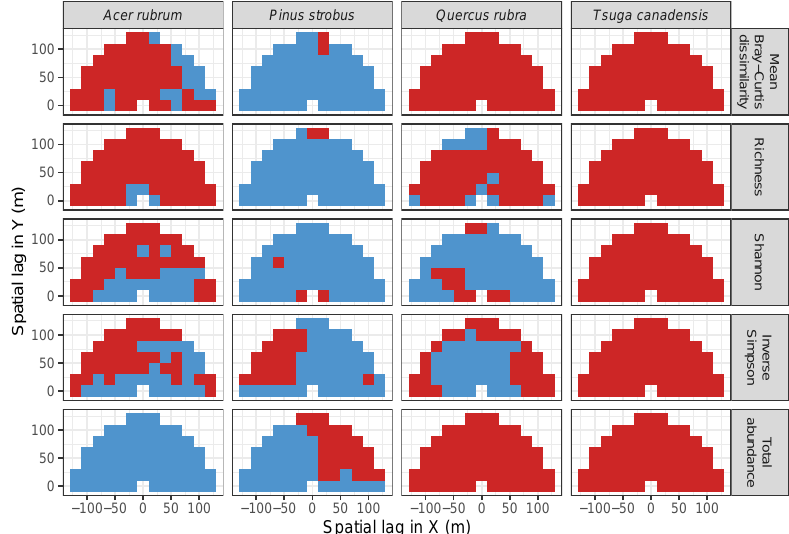
Figure 10. Statistical significance (red: P 0.05; blue: P > 0.05) of the codispersion coefficients calculated between measures of diversity and total basal area of the four dominant species in 20 subplots in the 35-ha Harvard Forest plot (Figure 8). Statistical significance was determined by comparing observed codispersion at each spatial lag with a distribution of 199 spatial randomizations of a CSR null model.